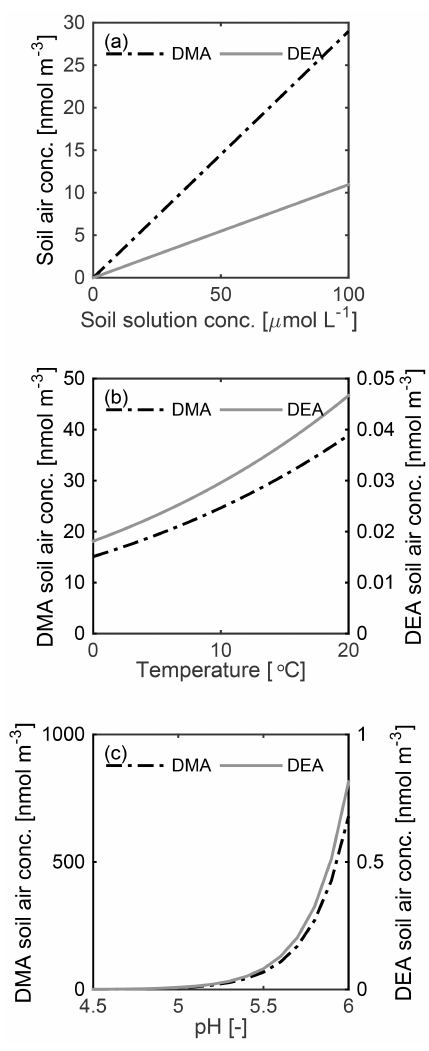
Figure 3. Effects of soil solution concentration (a) , soil temperature (b) , and soil solution pH (c) on estimated soil air concentrations of dimethylamine (DMA) and diethylamine